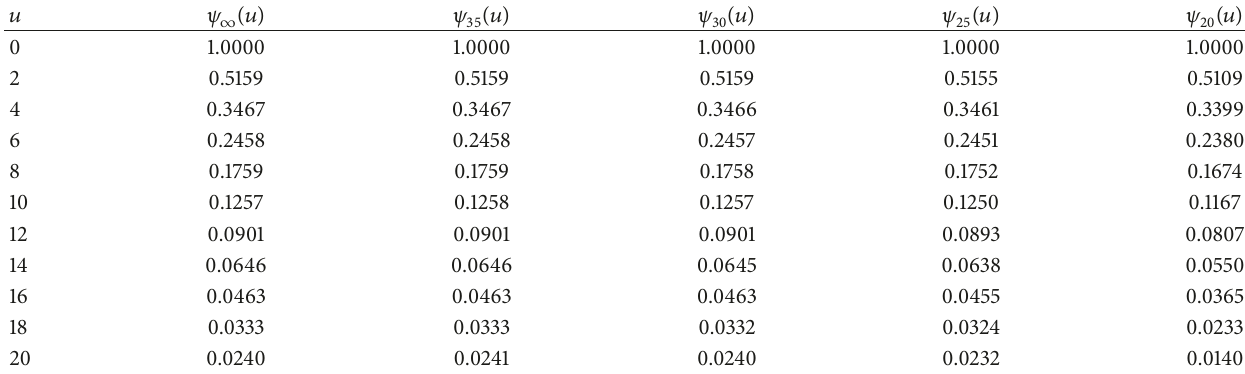
Table 3: Ruin probabilities for XL reins. in DPM: Exp(0.5) claims ( 𝜆 = 2, 𝑐 = 6,𝜎 = 0.02